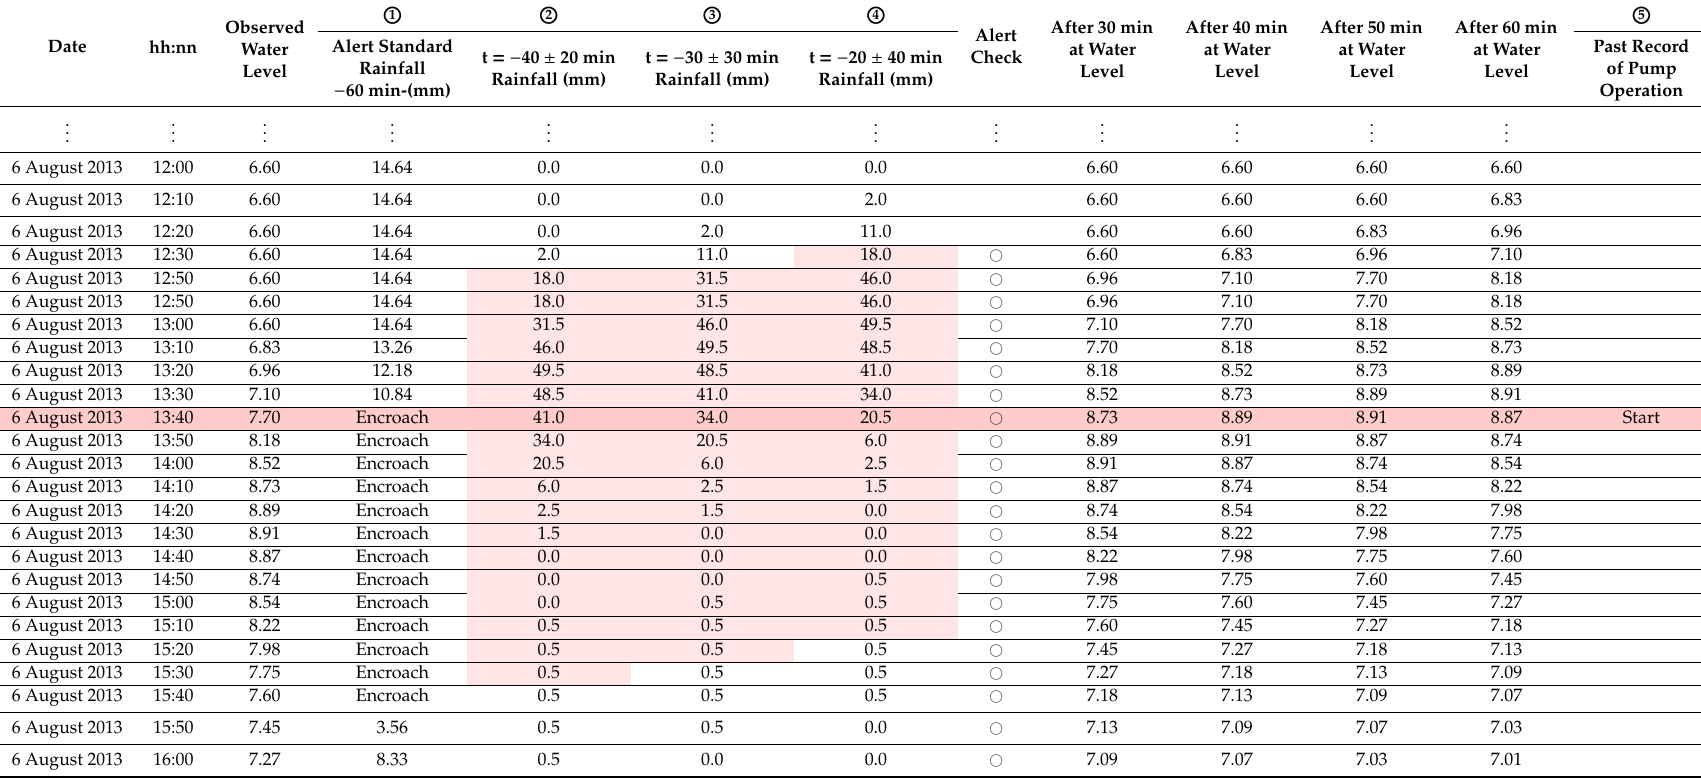
Table 11. Comparison of real-time water level observations in Dorim Stream (6 August